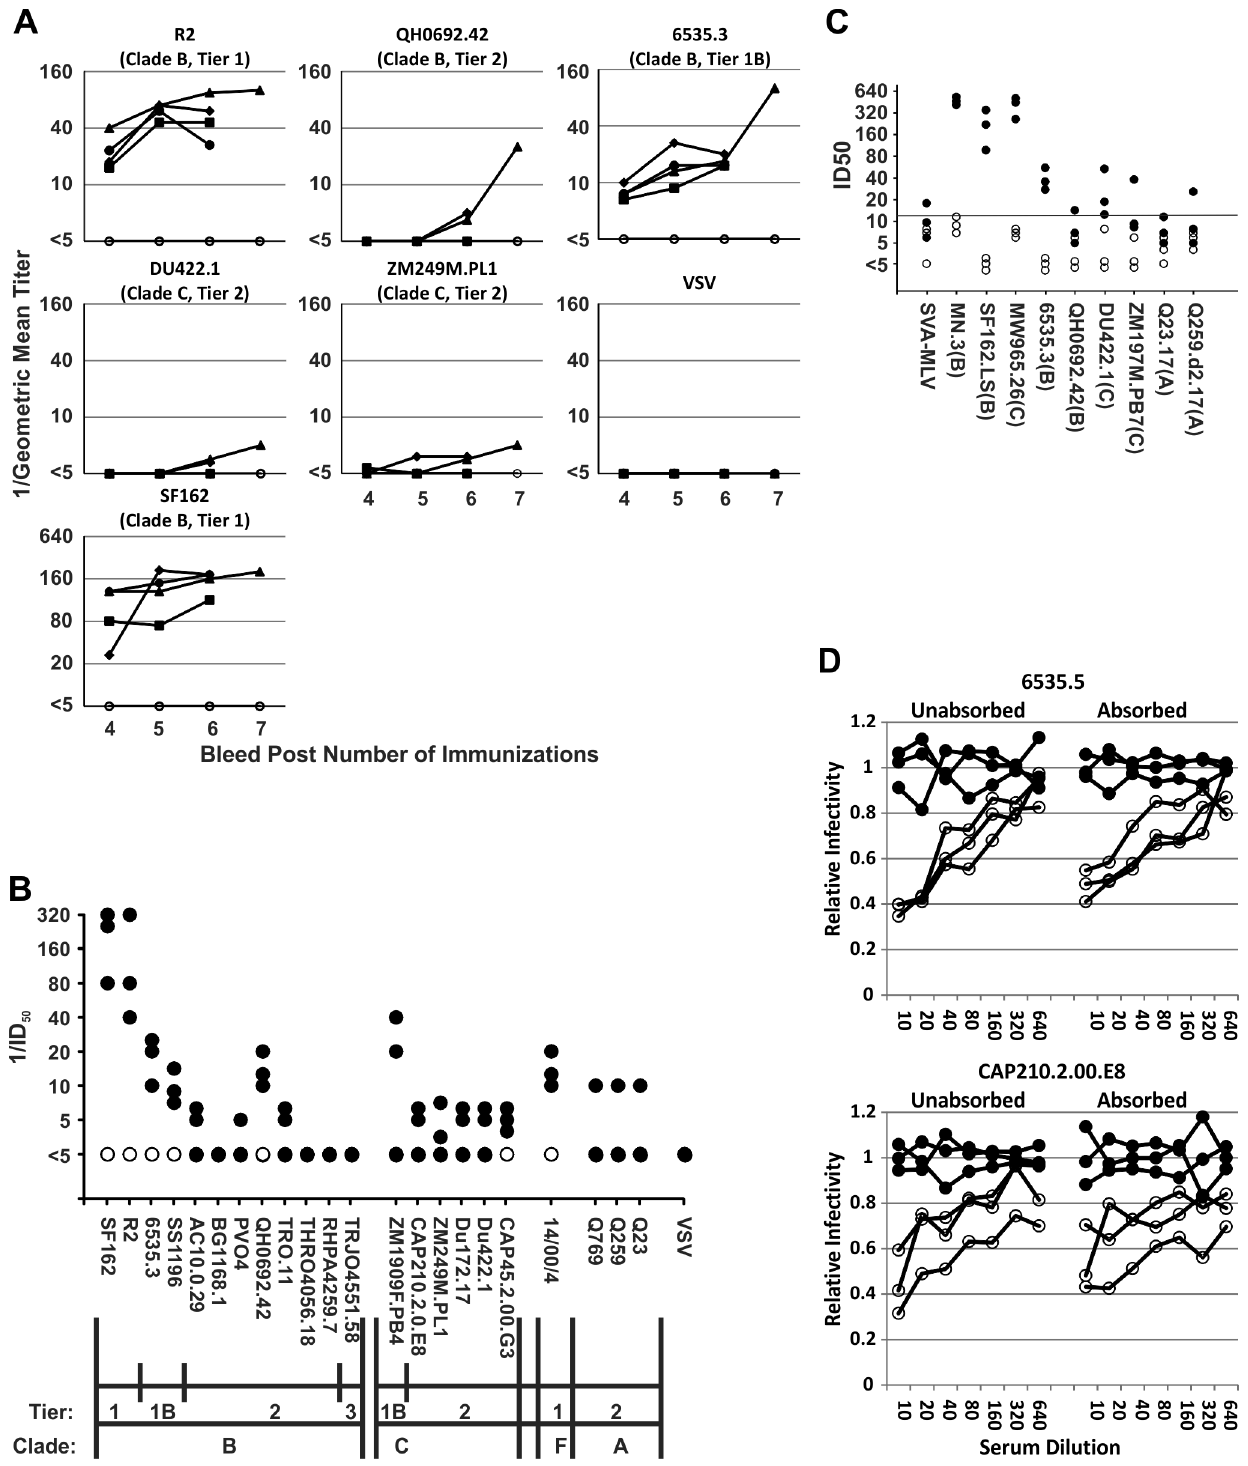
N Figure 3. Neutralizing antibody responses after serial immunizations with different forms of R2gp140. Rabbits received immunizations ), or saline ( # ) mixed with adjuvant in 0.5 ml containing 30 m g of wild type R2gp140 ( X ), R2gp140-GCN4 ( & ), R2gp140-GCN4-L ( m ), or R2gp140-L ( volumes divided subcutaneously in the hind legs. The first three immunizations were administered at 4 week intervals in the adjuvant AS01 B . Immunizations four through seven were administered at weeks 26, 46, 53, and 69. The adjuvant was changed to AS02 A for the last three immunizations. Only three rabbits in the gp140-GCN4-L group and three controls received the seventh immunization. Rabbits were bled approximately 10 days after each immunization. (A) Results shown are geometric means for each immunization group, two separate assays for each rabbit. Sera were tested at serial dilutions beginning at 1:5. Luminescence values obtained with test sera were compared to negative control sera to determine the highest dilution resulting in $ 50% neutralization, which was assigned as the endpoint. VSV-G protein pseudotyped virus was used as a PLOS ONE |